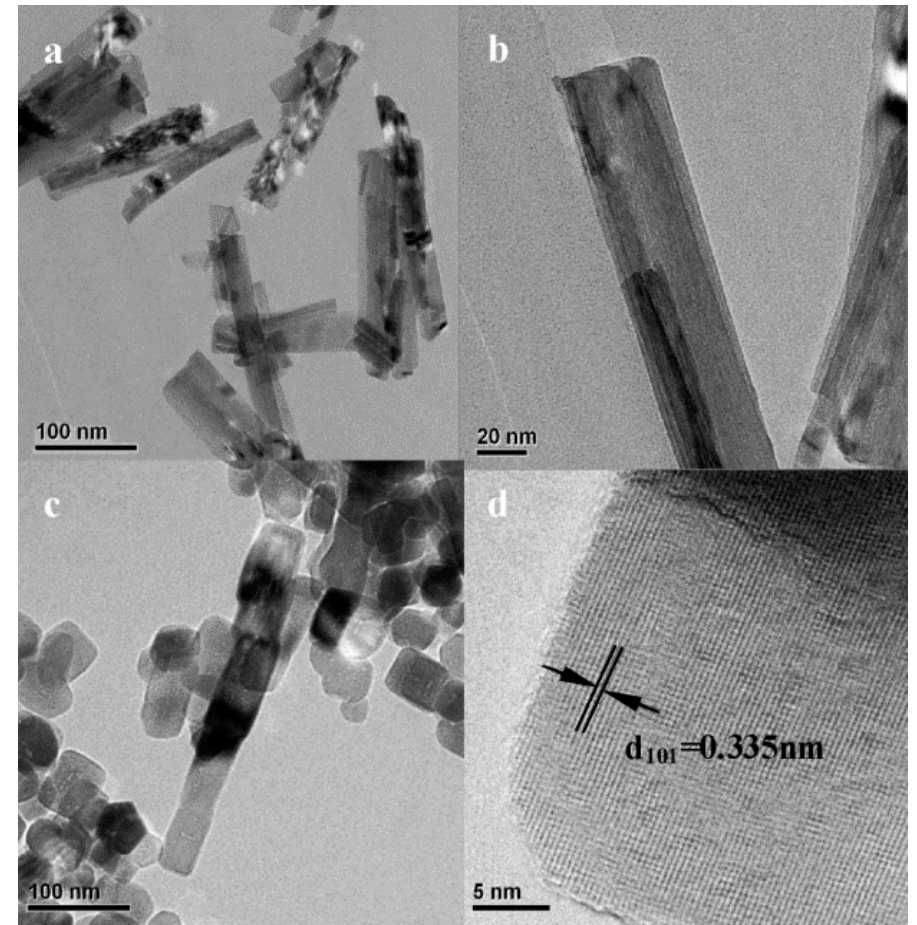
Figure 5 . ( a , b ) TEM images of titanate nanotubes prepared by hydrothermal reaction. © transmission electron microscopy (TEM) images and ( d ) high resolution transmission electron microscopy (HRTEM) image of 100 × 10 − 6 Fe 3+ doped TiO 2 . (Reproduced with permission from Elsevier [36]).